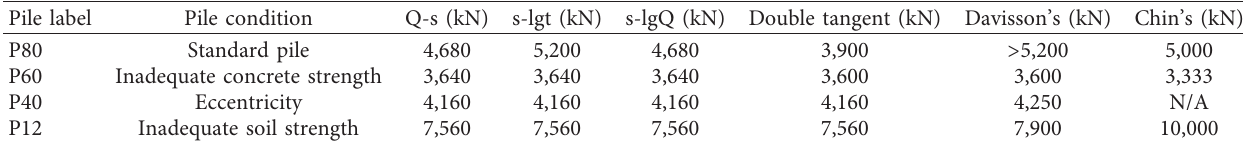
Table 3: Summarization of the pile